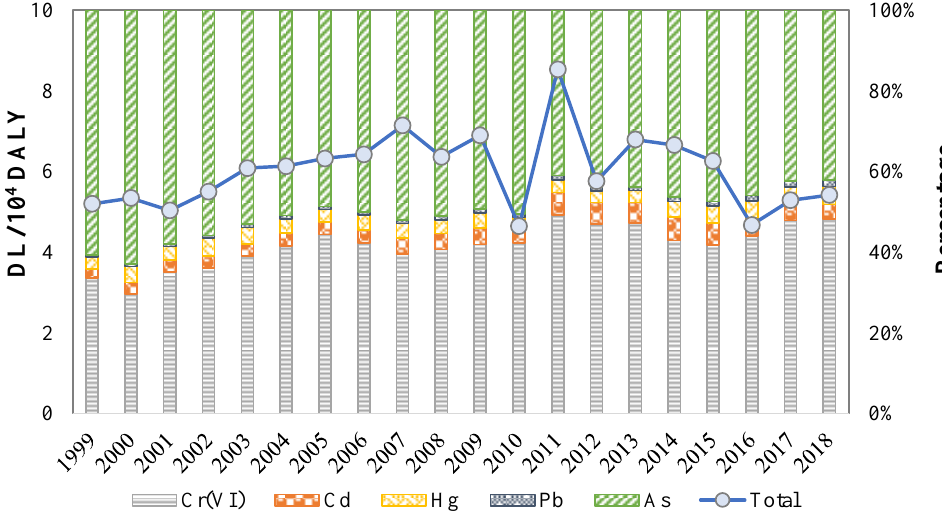
Figure 3. The contribution proportions of DL of five heavy metals.